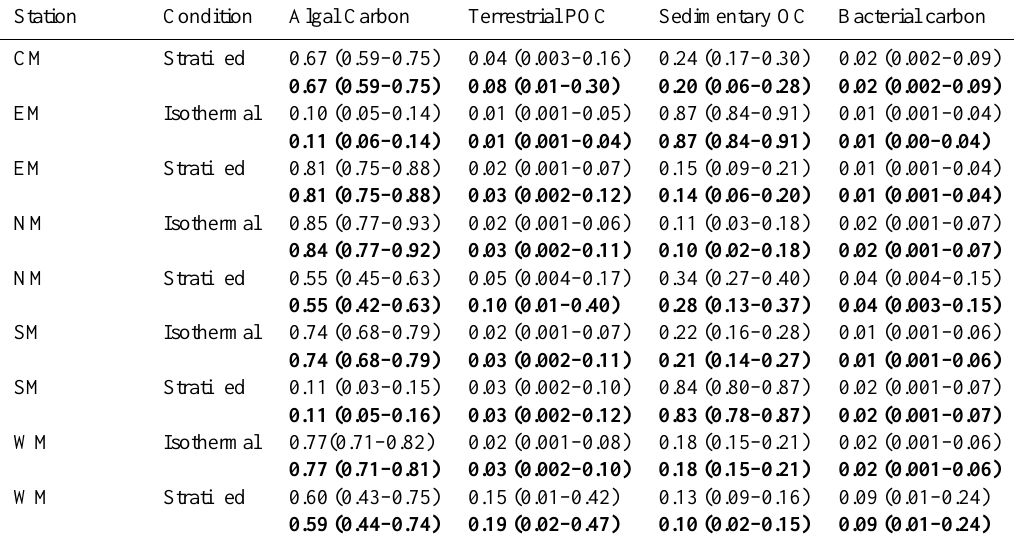
Table 3. Proportional median contribution of various food resources to the bulk POM in the water column of Lake Superior. The Bayesian MixSIR model was used for these calculations with algal carbon from recent photosynthesis, terrestrial POC, sedimentary carbon, and bacterial biomass as endmembers (as described in Sect. 2.4.1). The values in parentheses are the 5% and 95% confidence percentiles. The regular values are model estimates when 1 14 C of corn leaves and δ 13 C of terrigenous POC are used as the terrestrial endmember; bold values are when 1 14 C and δ 13 C of POC from high flow Amity Creek is used as the terrestrial